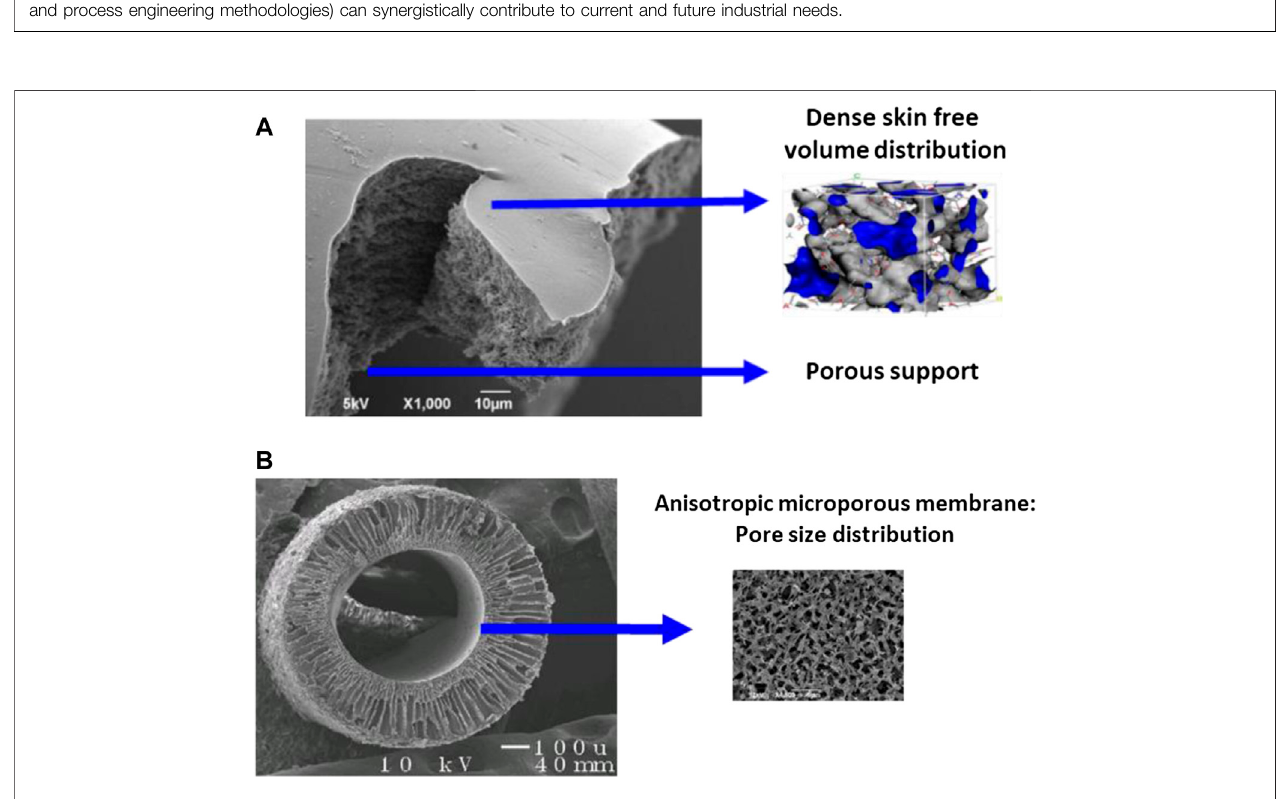
FIGURE 2 | Examples of current industrial membrane materials. (A) Dense skin asymmetric polymeric membrane (reverse osmosis, gas separations). Productivity constraintsrequireaverythindenselayersupportedonaporousstructure.Theseparationperformancesresultfromspeciessolubilityanddiffusionintoasubnanometer free volume distribution matrix. (B) Porous membrane (ultra fi ltration, micro fi ltration, dialysis, membrane contactors, and transmembrane distillation). The porous separating layer, shows a pore size distribution in the nanometer to micrometer range, depending on the liquid mixture to be treated and species to be treated be separated. This type of structure can be based on polymeric or inorganic